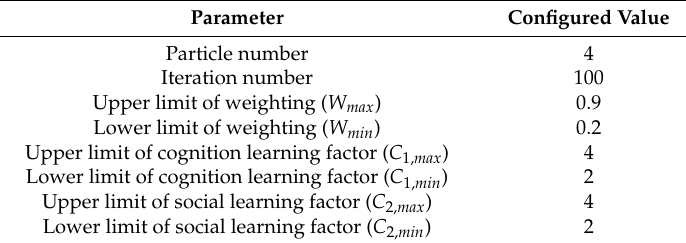
Table 2. Parameter configuration of the conventional PSO. Table 3. Parameter configuration of the modified PSO.